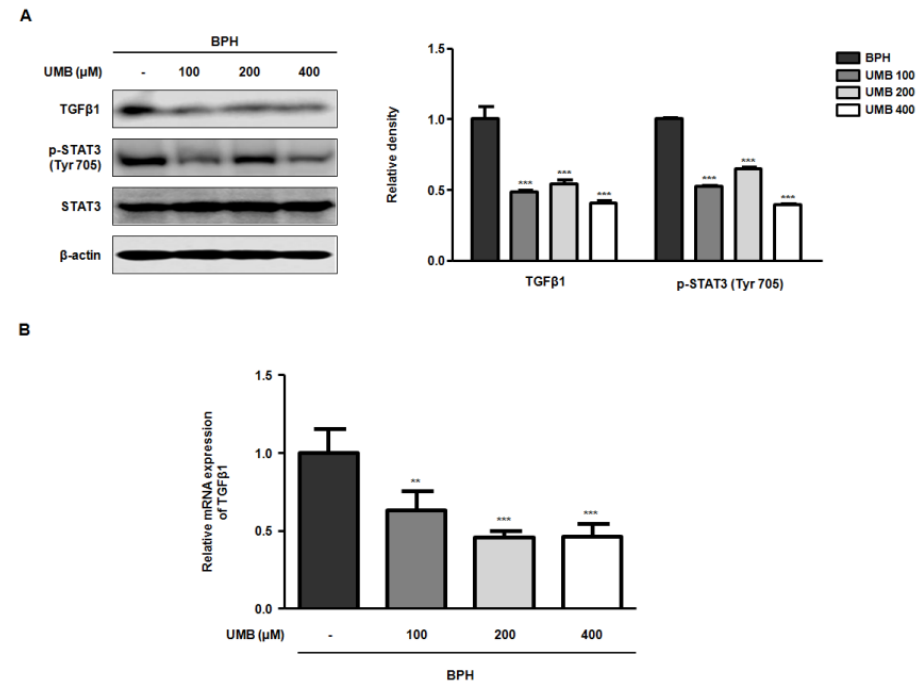
Figure 4. Effect of UMB treatment on TGF β 1 and p-STAT3 (Tyr 705) expression in BPH-1 cells. ( A , B ) BPH-1 cells were treated with or without 100, 200, and 400 µ M of UMB. ( A ) Protein expression of TGF β 1 and p-STAT3 (Tyr 705) was determined by Western blot analysis using specific antibodies. The relative protein density was normalized to that of β -actin, which was used as an internal control. ( B ) The mRNA expression of TGF β 1 was quantified using qRT-PCR in BPH-1 cells. The relative mRNA expression was normalized using the Ct value of β -actin. The values represent as mean ± S.D. of three independent experiments. ** p < 0.01, *** p < 0.001 vs. vehicle control.